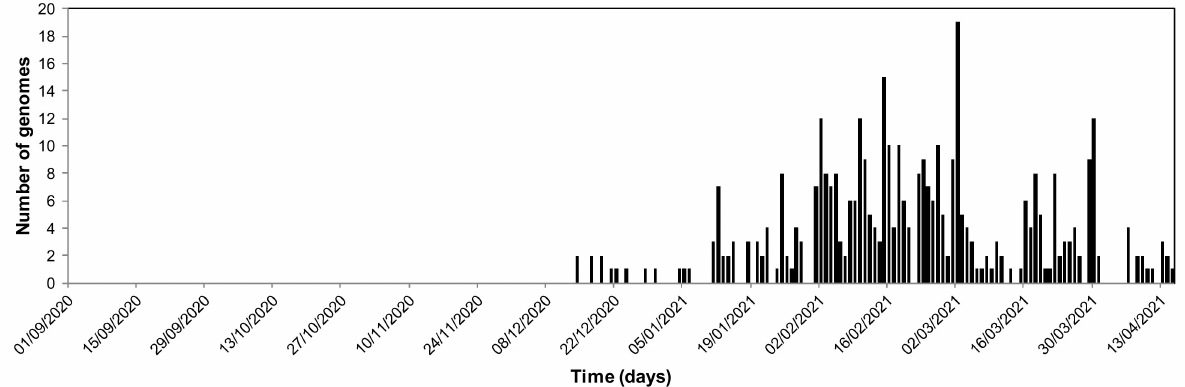
Figure 1. Example of the emergence of the Marseille-501 SARS-CoV-2 spike variant (lineage A.27) in 2020 (number of sequences available from the GISAID database (https://www.gisaid.org/, accessed on 26 May